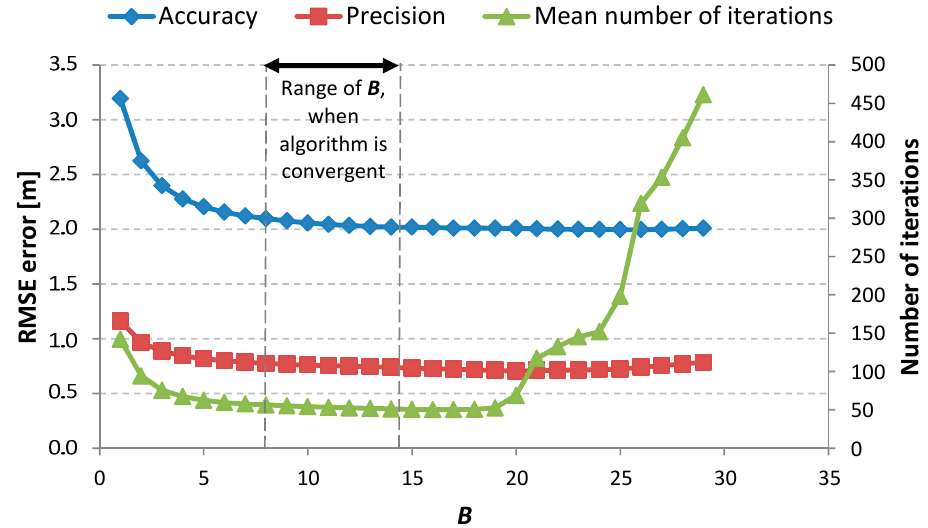
Figure 5. The relationship between the value of parameter 𝐵 and the accuracy, precision, and mean number of iterations when all devices were deployed inside an inhabited single-family house; 𝐴 = 1.1.